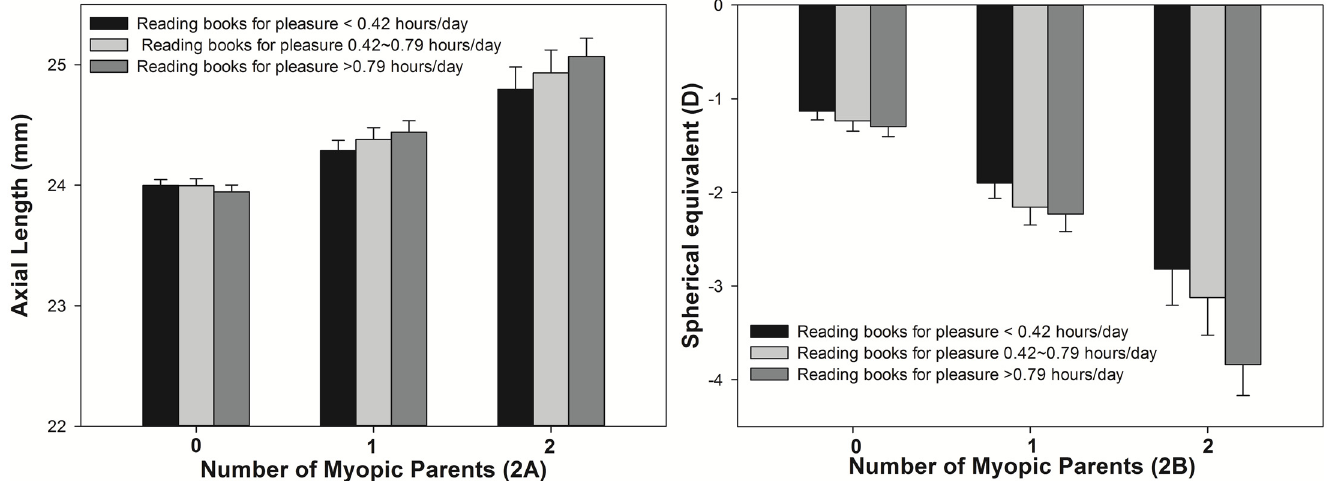
Fig 2. Age-gender-height adjusted axial lengths (2A, mm, mean ± SEM, P = 0.04) and spherical equivalent (2B, D, mean ± SEM, P = 0.05) by reading books for pleasure per week and parental myopia using general linear model.